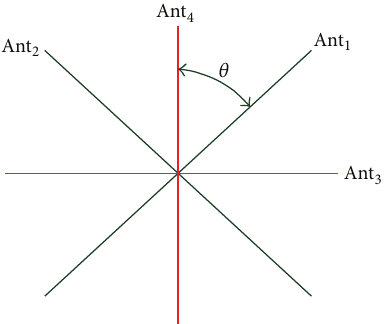
Figure 3: Transmitting antenna and receiving antenna configura- tion.